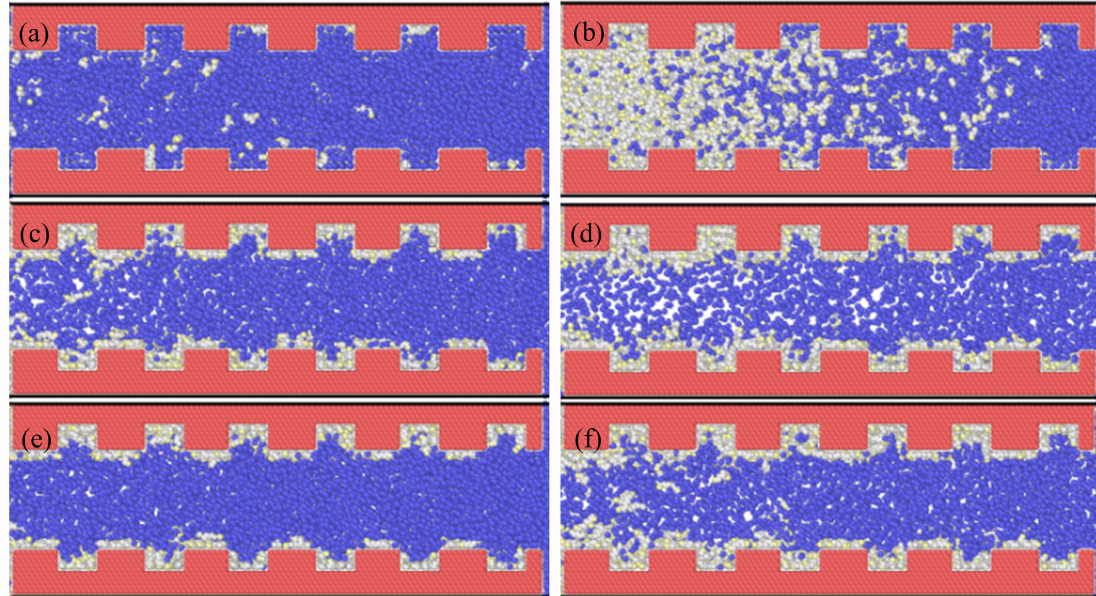
Figure 3. Final snapshots of single-component systems: ( a ) CO 2 with constant-rate injection; ( b ) CO 2 without constant-rate injection; ( c ) CH 4 with constant-rate injection; ( d ) CH 4 without constant-rate injection; ( e ) N 2 with constant-rate injection; ( f ) N 2 without constant-rate injection. The color code is the same as in Figure